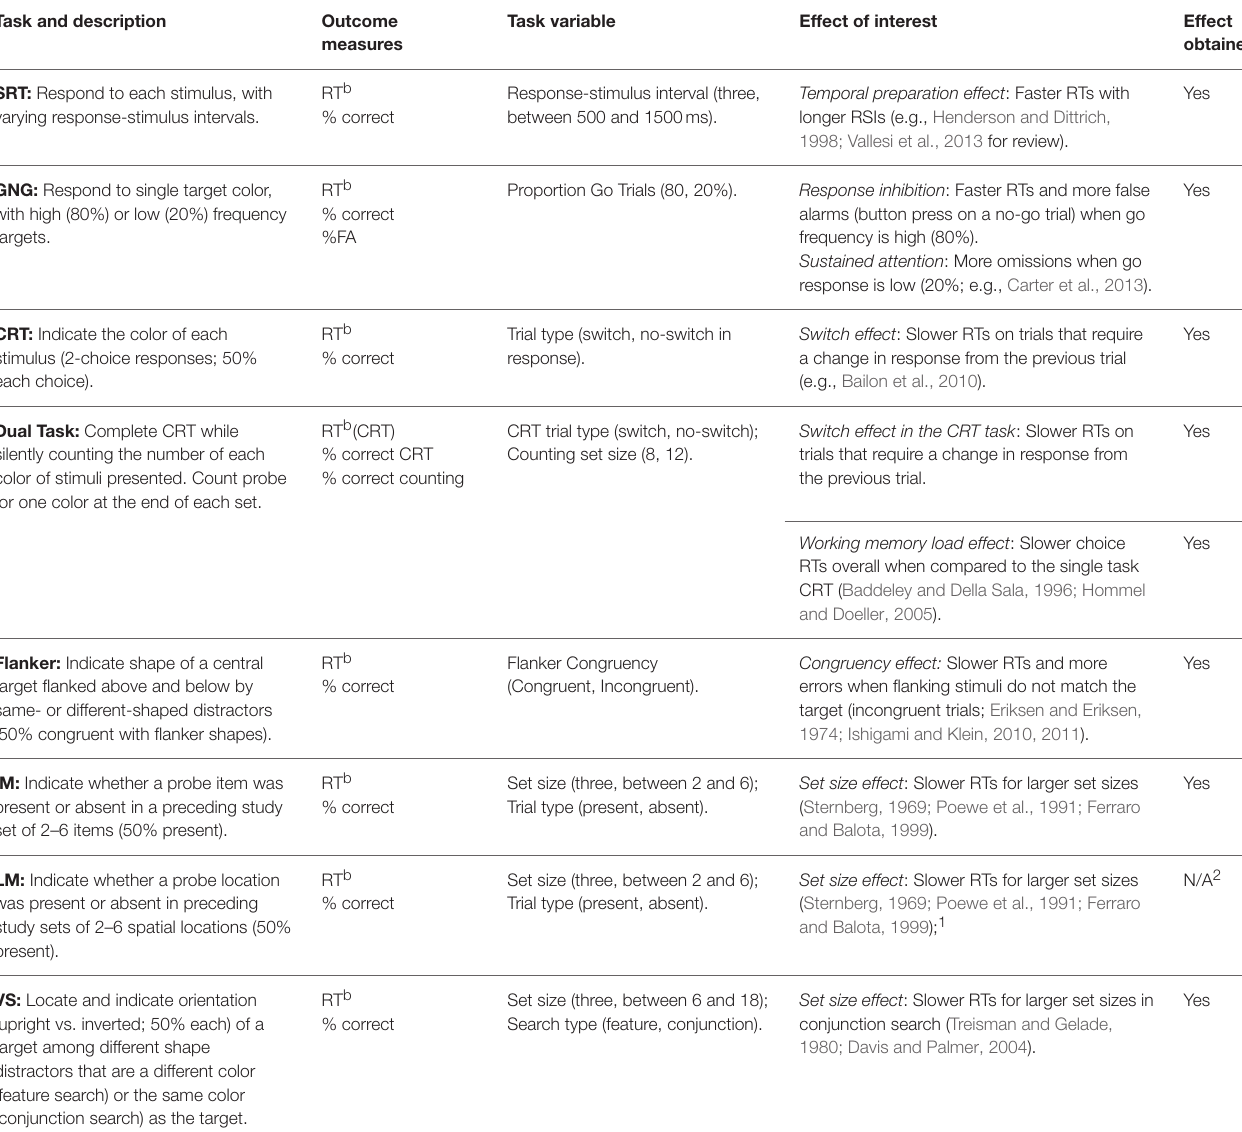
TABLE 1 | DalCAB task descriptions, outcome measures, and task-related variables and effects of interest. Task and description Outcome Task variable Effect of interest Effect measures